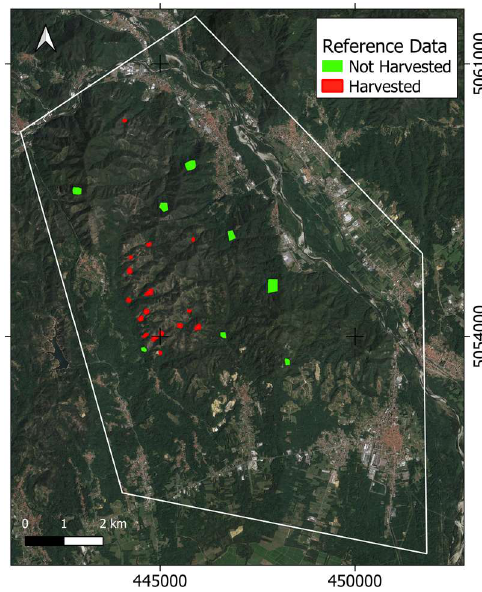
Figure 2 . Harvested and not- harvested reference polygons location in AOI. Reference frame is WGS84 UTM